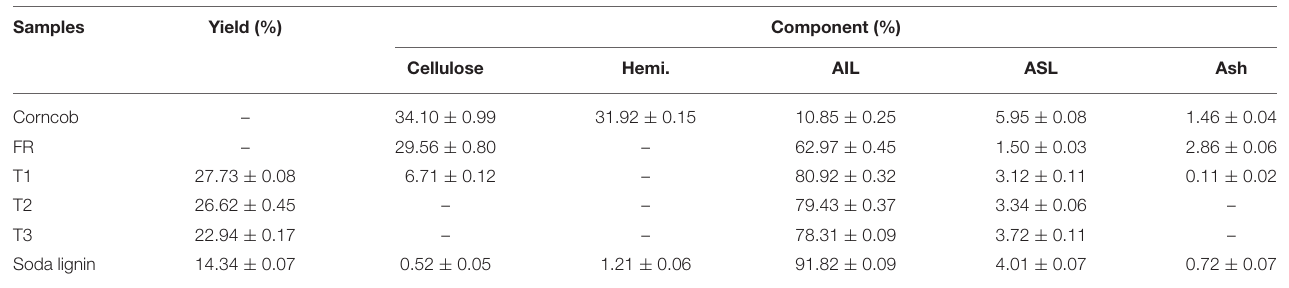
TABLE 2 | Yield and chemical composition of corncob, furfural residue and extracted lignin samples. Samples